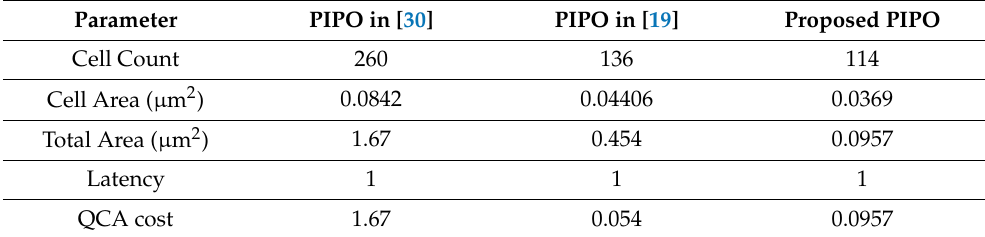
Table 8. Performance comparison of proposed 4-bit PIPO shift